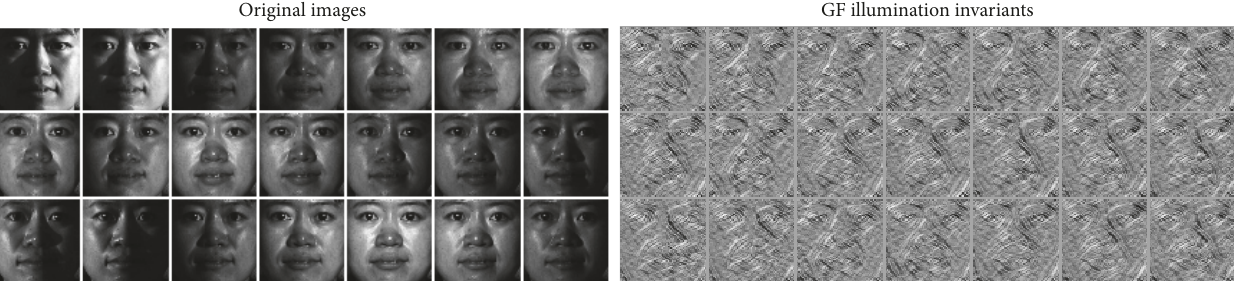
Figure 11: Images of a person in C27 and their illumination invariants using